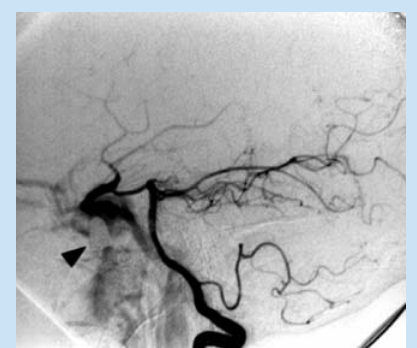
Fig. 3. Lateral vertebral artery angiogram with carotid compression — Heuber maneuvre. Note filling of anterior circulation and fistula via posterior communicating artery. Bullet in the cavernous sinus is visible (arrow).